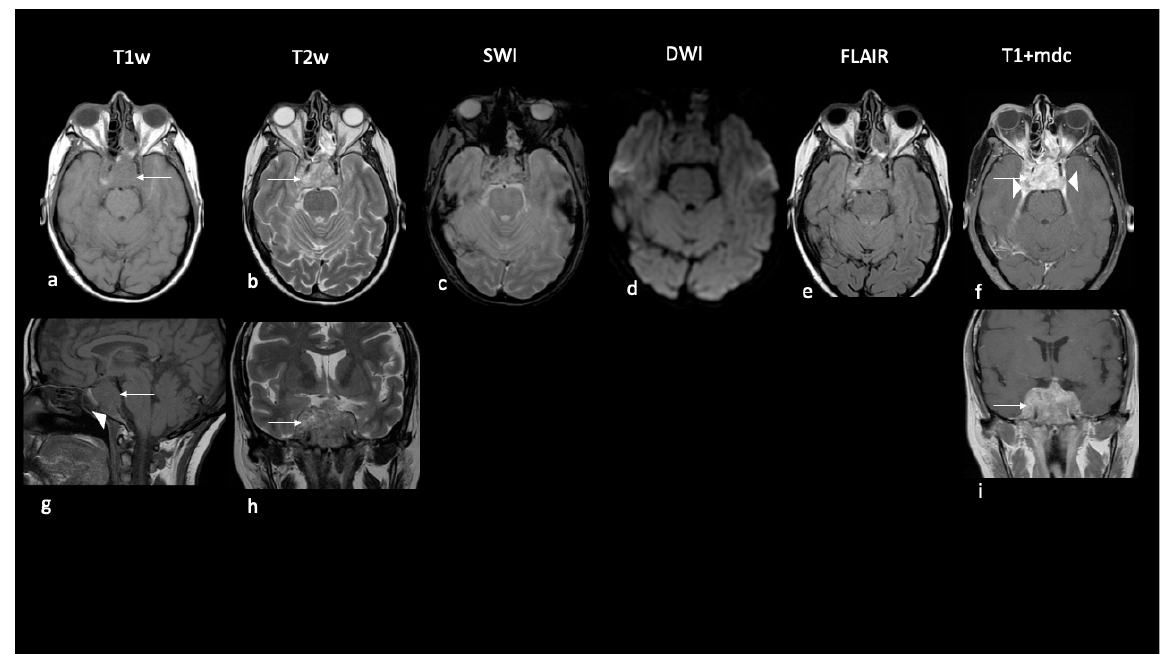
Figure 3. Imaging findings of sellar ATRT in an adult. Ax T1w ( a , g ); Ax T2w ( b , h ); SWI ( c ); Ax DWI ( d ); Ax FLAIR ( e ); Ax T1w+mdc ( f , i ). A local aggressive mass centered in the sellar region in an adult of 43 years. The mass is prevalently solid, hypointense in T1w (arrows in ( a , g )) and hyperintense in T2w (arrows in ( b , h )) to gray matter with marked enhancement (arrow in ( f , i )) invading cavernous sinus (arrowheads in ( f )) and clivus (arrowhead in ( g )). Decreased diffusivity and interstitial edema are absent. In four pediatric patients (40%), tumors showed leptomeningeal spreading at diagnosis, either in intracranial cerebrospinal fluid (CSF) or in intracranial and spinal CSF (Figure 4).